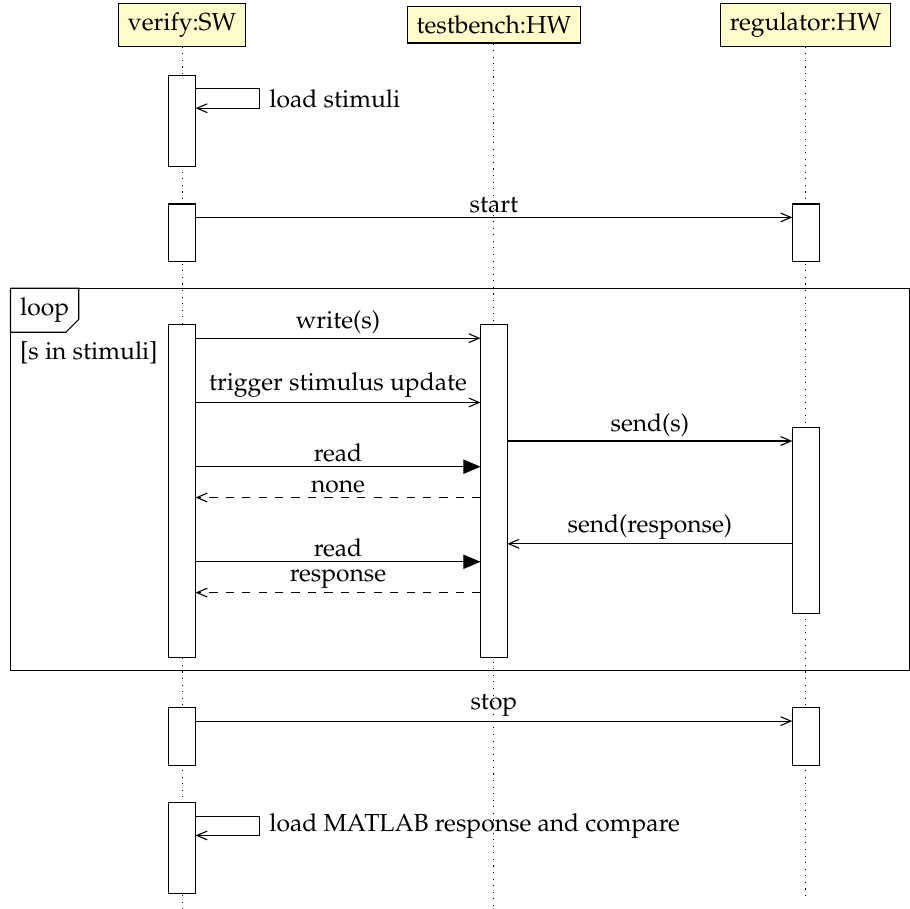
Figure 19. UML sequence diagram showing the operation of the BBF regulator testbench